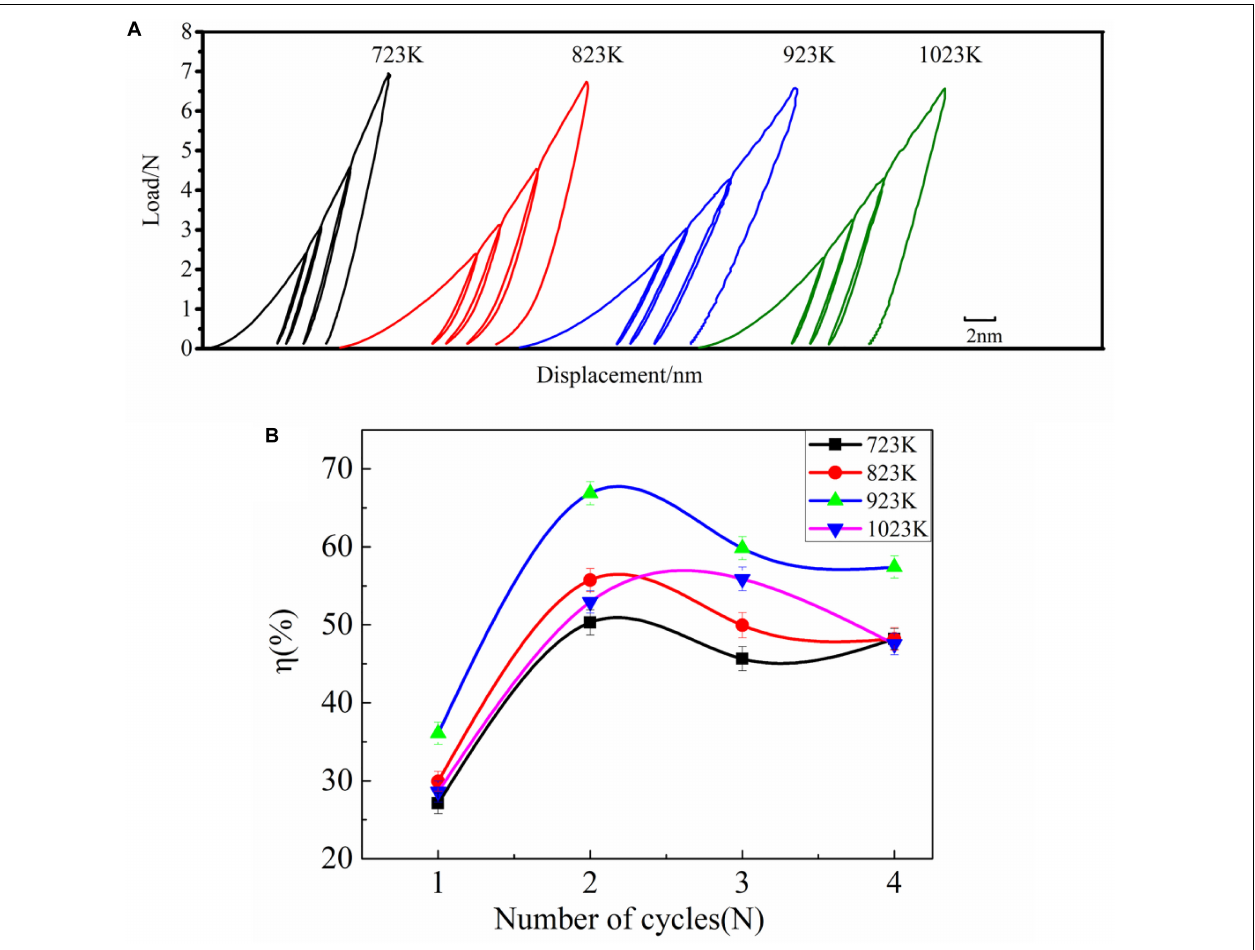
FIGURE 7 | (A) Representative load-displacement curves of four continuous loading and unloading of 723,823, 923, and 1023 K. (B) The elastic recovery rate of four continuous loading and unloading at 723, 823, 923, and 1023